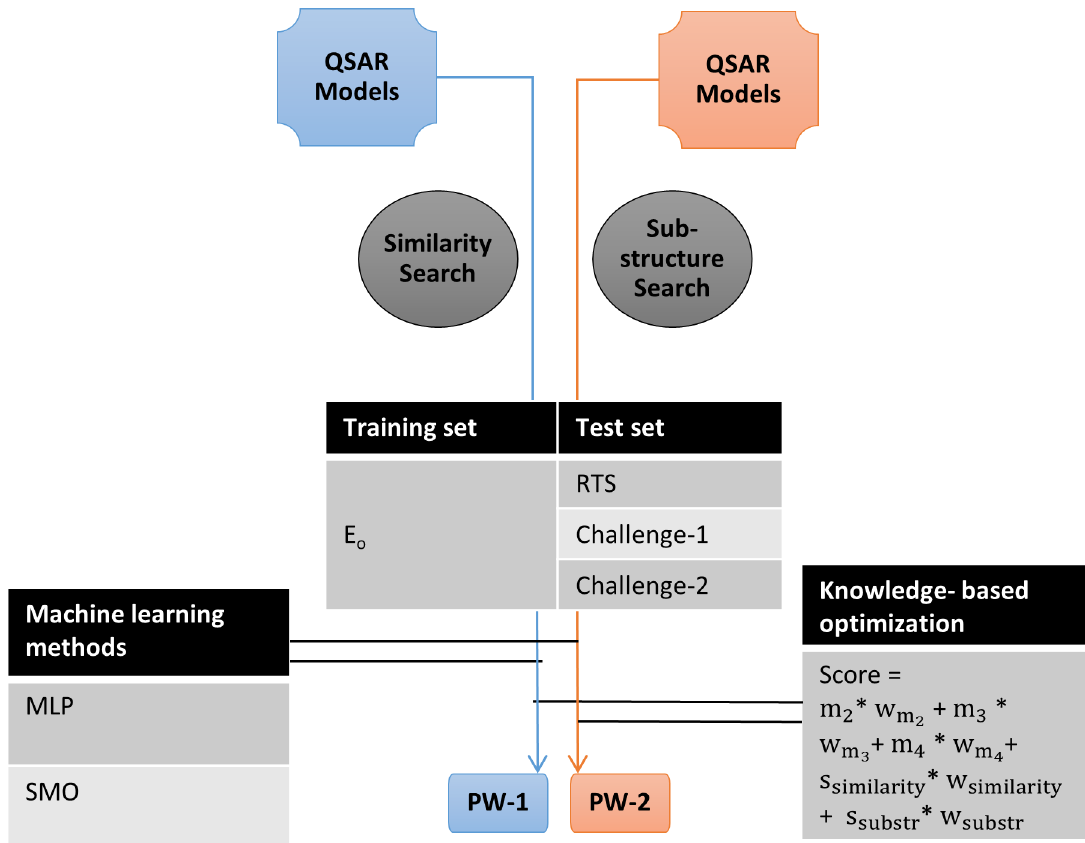
Fig 3. Integration of QSAR models, similarity information and sub-structure pattern into prediction workflows (PWs). Blue and red colors depict components that differ in the two Prediction Workflows, PW-1 and PW-2. Components in black and grey are those that are common in both PW-1 and PW-2. QSAR: Quantitative Structure-Activity Relationship; MLP: Multi- Layer Perceptron; SMO: Sequential Minimal Optimization; E o : Energy-optimized dataset; RTS: Representative test set; Challenge-1: Challenge set-1; Challenge-2: Challenge set-2; m 2 , m 3 , m 4 , s similarity and s substr are predictions from QSAR. models-2, 3 and 4, similarity information and sub-structure pattern, and w m2 , w m3 , w m4 , w similarity and w substr are their corresponding